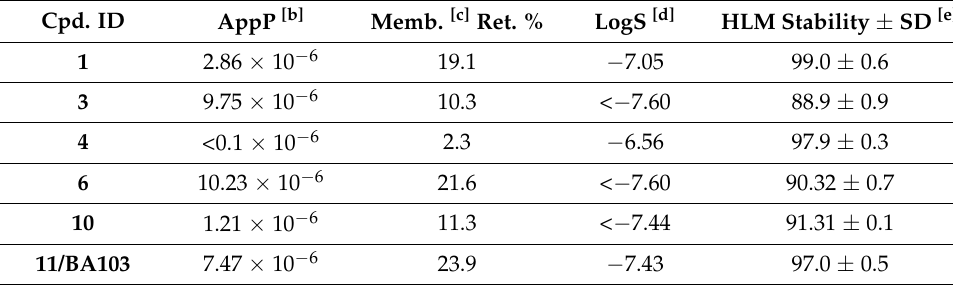
Table 4. In vitro ADME evaluation of selected compounds [a] .